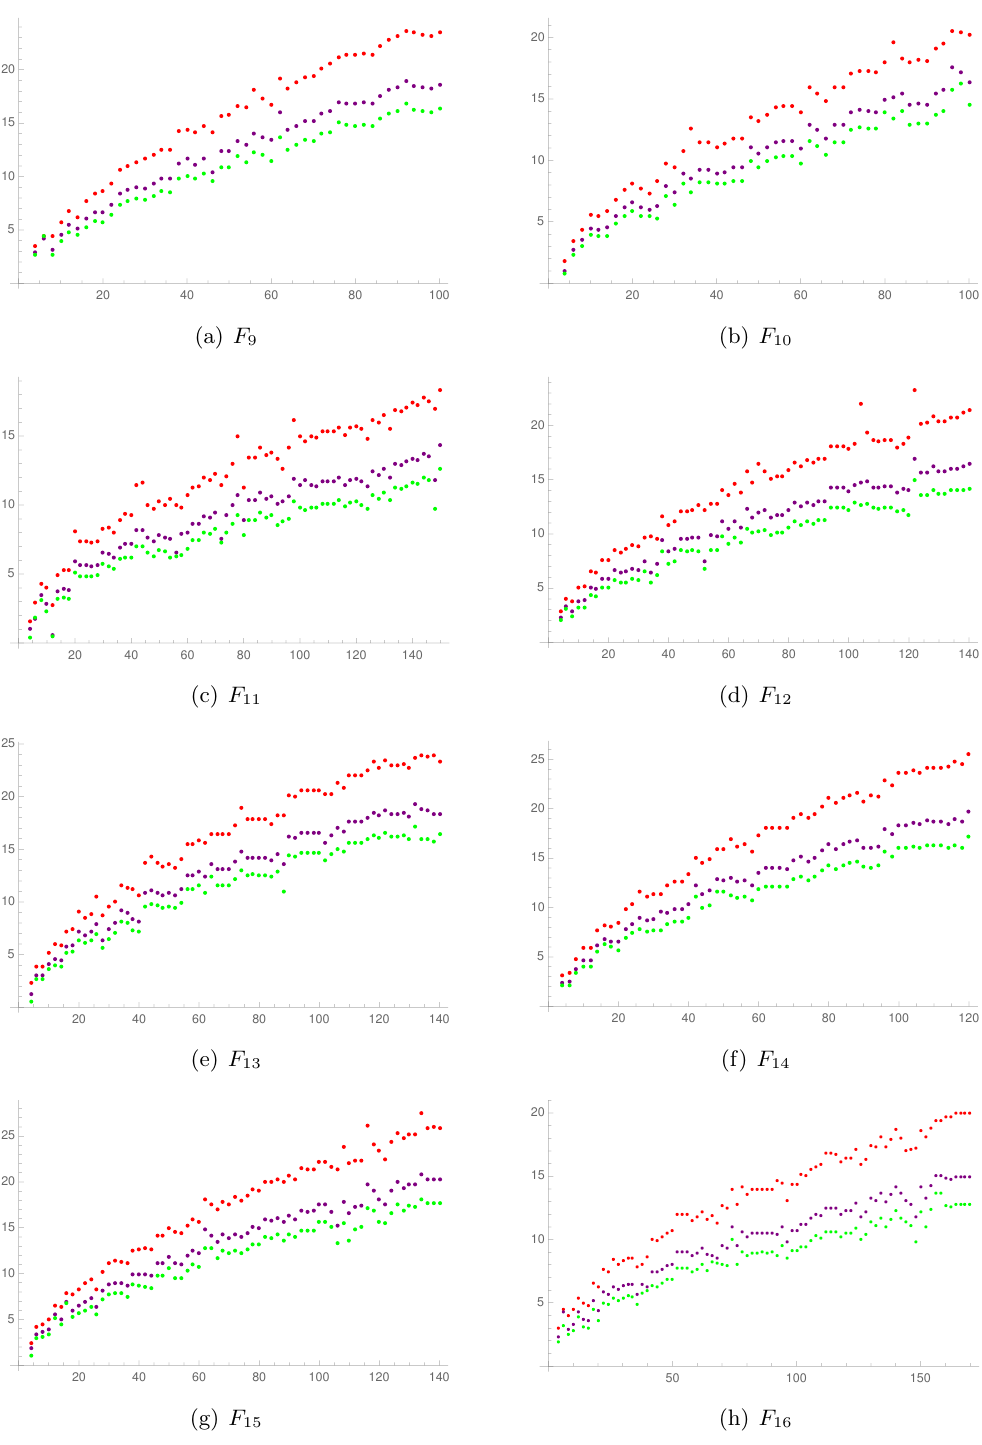
Figure 4 . Same as in (cid:12)gure 3 for F 9 ; : : : ; F 16 with ~ = (cid:25) (red), ~ = 11 (cid:25)= 7 (purple), and ~ = 2 (cid:25)